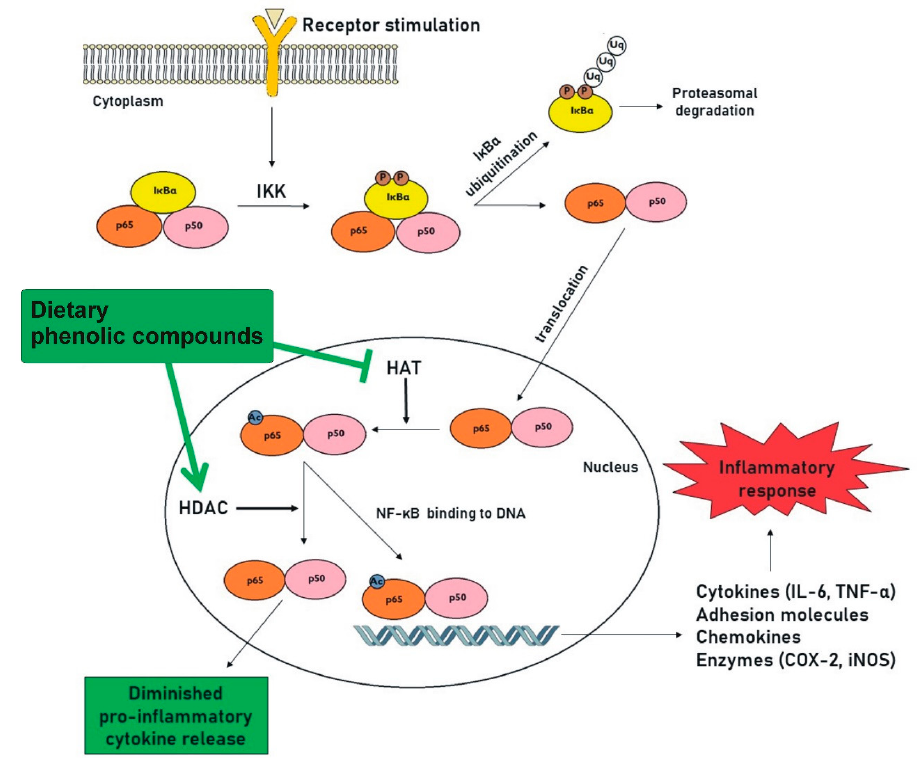
Figure 2. The regulation of inflammatory response by dietary phenolic compounds through HAT inhibition or HDAC activation. NF- κ B is a nuclear factor responsible for the transcription of genes connected to inflammatory immune response. It is found in cytoplasm associated with its inhibitory subunit I κ B α , which masks the nuclear translocation signal. Upon cell stimulation, the inhibitory subunit is phosphorylated by I κ B kinase (IKK), which leads to its ubiquitination and degradation by proteasome. The released NF- κ B dimer (consisting of the p65 and p50 subunits) is then translocated into the nucleus and initiates the expression of genes, including genes for various mediators that intensify inflammatory response. HATs and HDACs have been implicated in regulating NF- κ B activity. While HATs have a role in NF- κ B-mediated transcriptional activation, HDACs have been shown to reverse this process and to repress NF- κ B-mediated gene transcription. Many dietary phenolic compounds show a potential to modulate NF- κ B-mediated inflammation through the regulation of HAT or HDAC activity. Ac: acetylation; COX-2: cyclooxygenase-2; HAT: histone acetyltransferase; HDAC: histone deacetylase; IKK: I κ B kinase; IL-6: interleukin 6; iNOS: inducible nitric oxide synthase; NF- κ